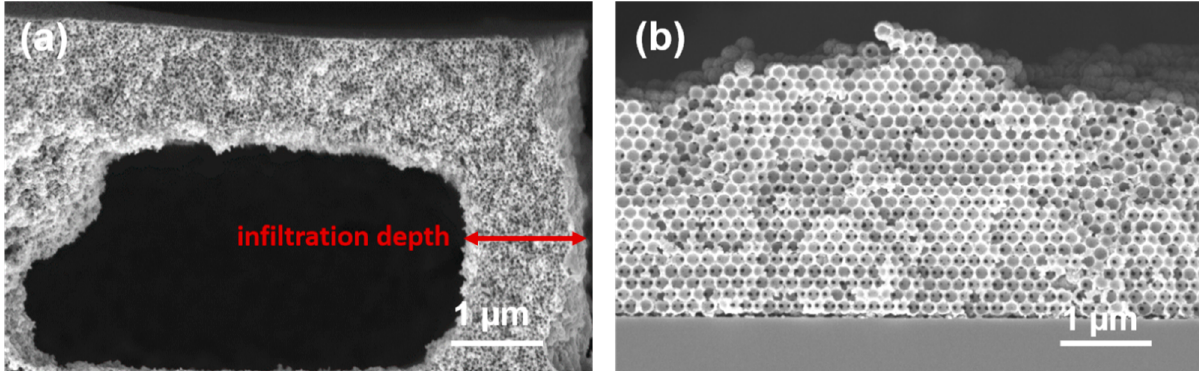
Figure 3. Cross-section SEM images of ZnO inverse opals obtained with ( a ) 60 nm sized PS particles and ( b ) 175 nm sized PS particles. Assembly conditions for both PS template films: 10 µL, 10 wt.% PS colloidal dispersion, withdrawal speed 0.3 mm/min, temperature 22.6 °C and humidity 53.8%, 3 ZnO mineralization cycles and solvent extraction.